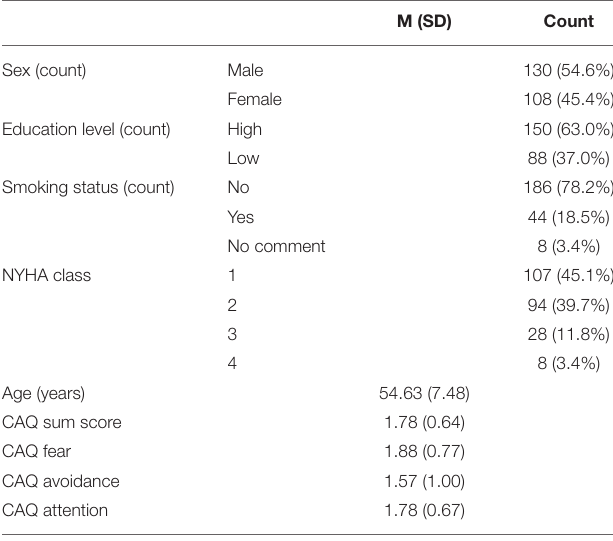
TABLE 1 | Sample characteristics, NYHA classification and CAQ scores ( N = 238).